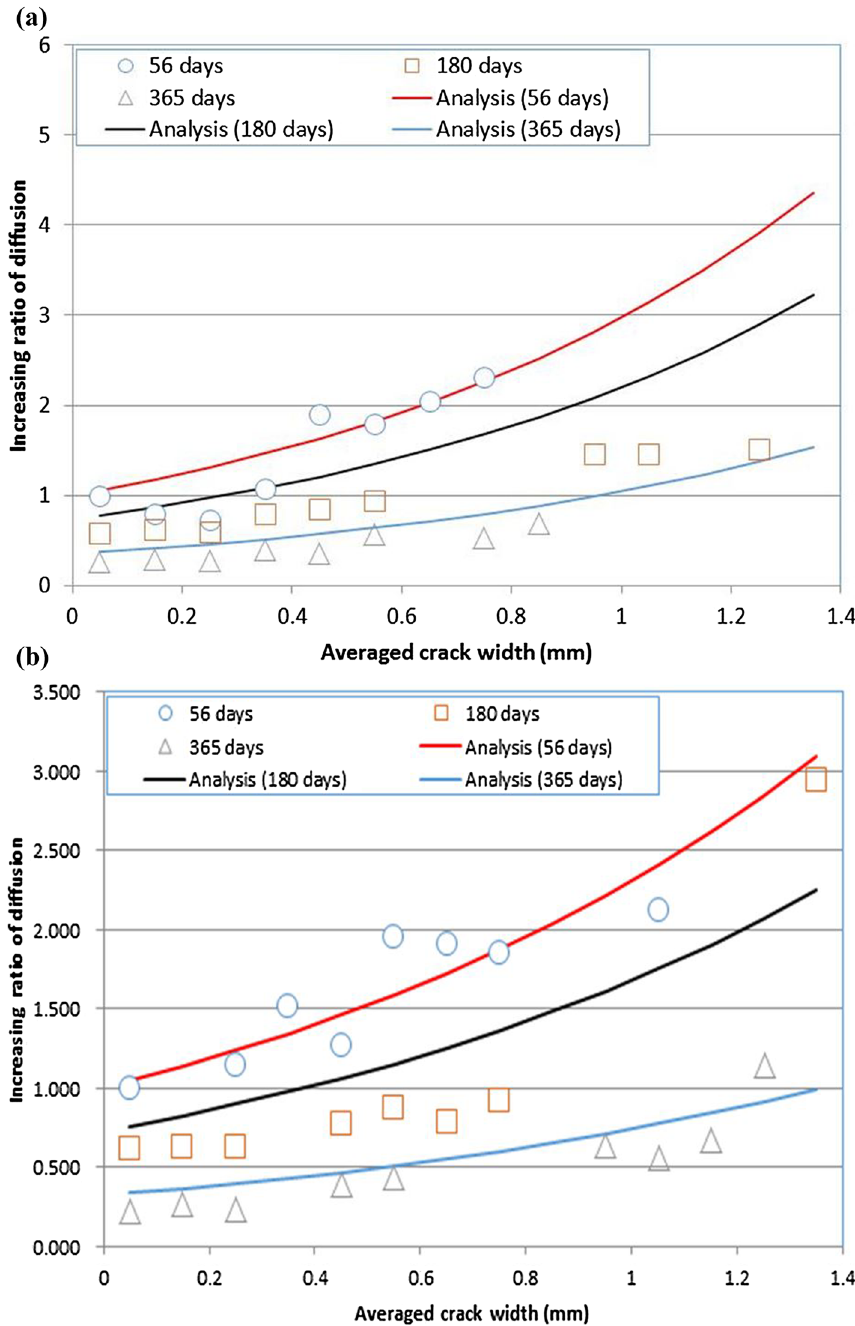
Fig. 8 Diffusion coefficient of test and regression analysis. a N-grade. b